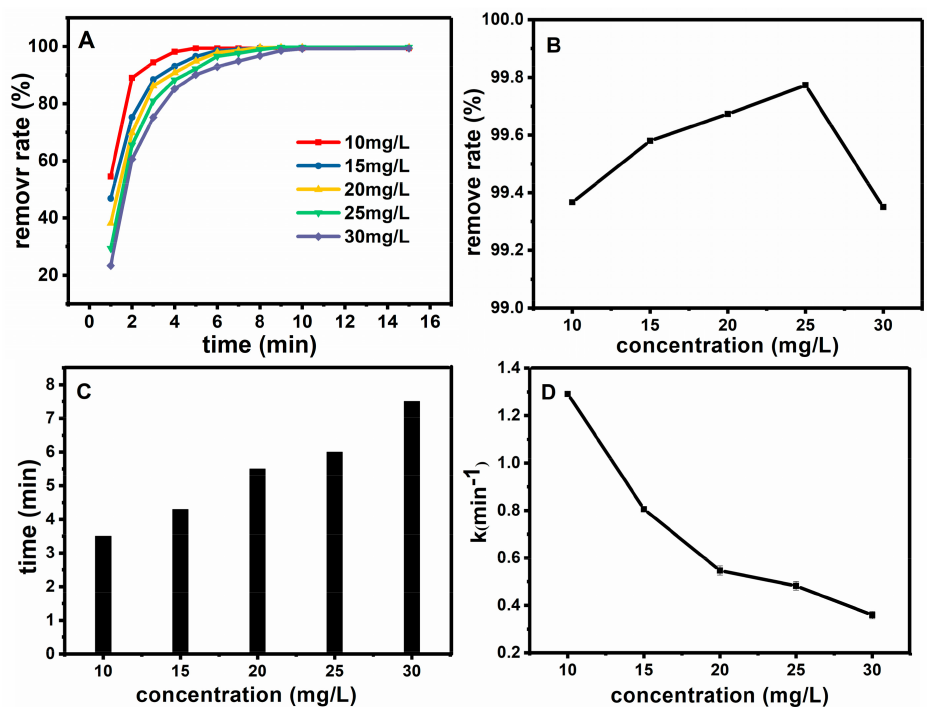
Figure 9. Effect of initial concentration of basic fuchsin on oxidation rate ( A ); The relationship between the initial concentration of basic fuchsin and the removal degree after half an hour ( B ); The relationship between initial concentration of basic fuchsin and time when the removal degree reached 98% ( C ); the relationship between initial concentration of basic fuchsin and the work rate ( D